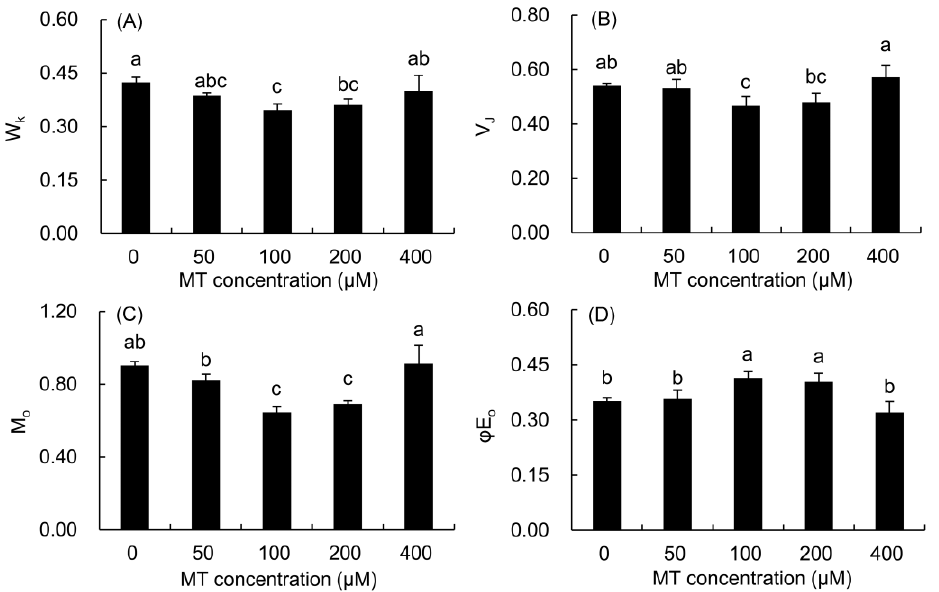
Figure 6. Effects of different concentrations of MT on W K ( A ), V J ( B ), M o ( C ) and φE 0 ( D ) of P. vulgaris. MT: melatonin. Data are means ± standard error; different letters indicate significant differences as determined by the Duncan test ( p ≤ 0.05).